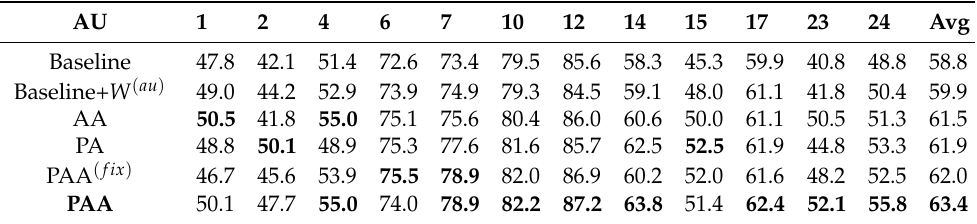
Table 5. F1-frame results for 12 AUs of different variants of PAA on BP4D [18]. The best results of each AU, as well as the average across methods, are shown in bold. The performance is gradually improved after adding the proposed